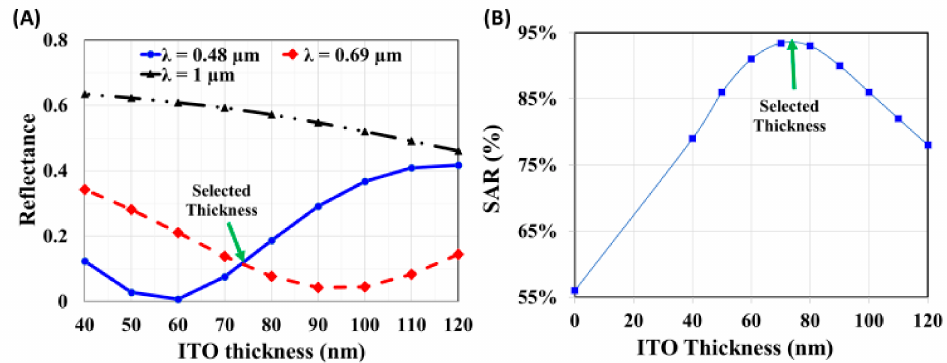
Figure 3. ( A ) Reflectance GaAs solar cell versus the ITO thickness at different incident wavelength ( λ = 0.48 µ m, 0.69 µ m, and 1 µ m). ( B ) Impact of changing the ITO thickness on the average spectral absorption rate